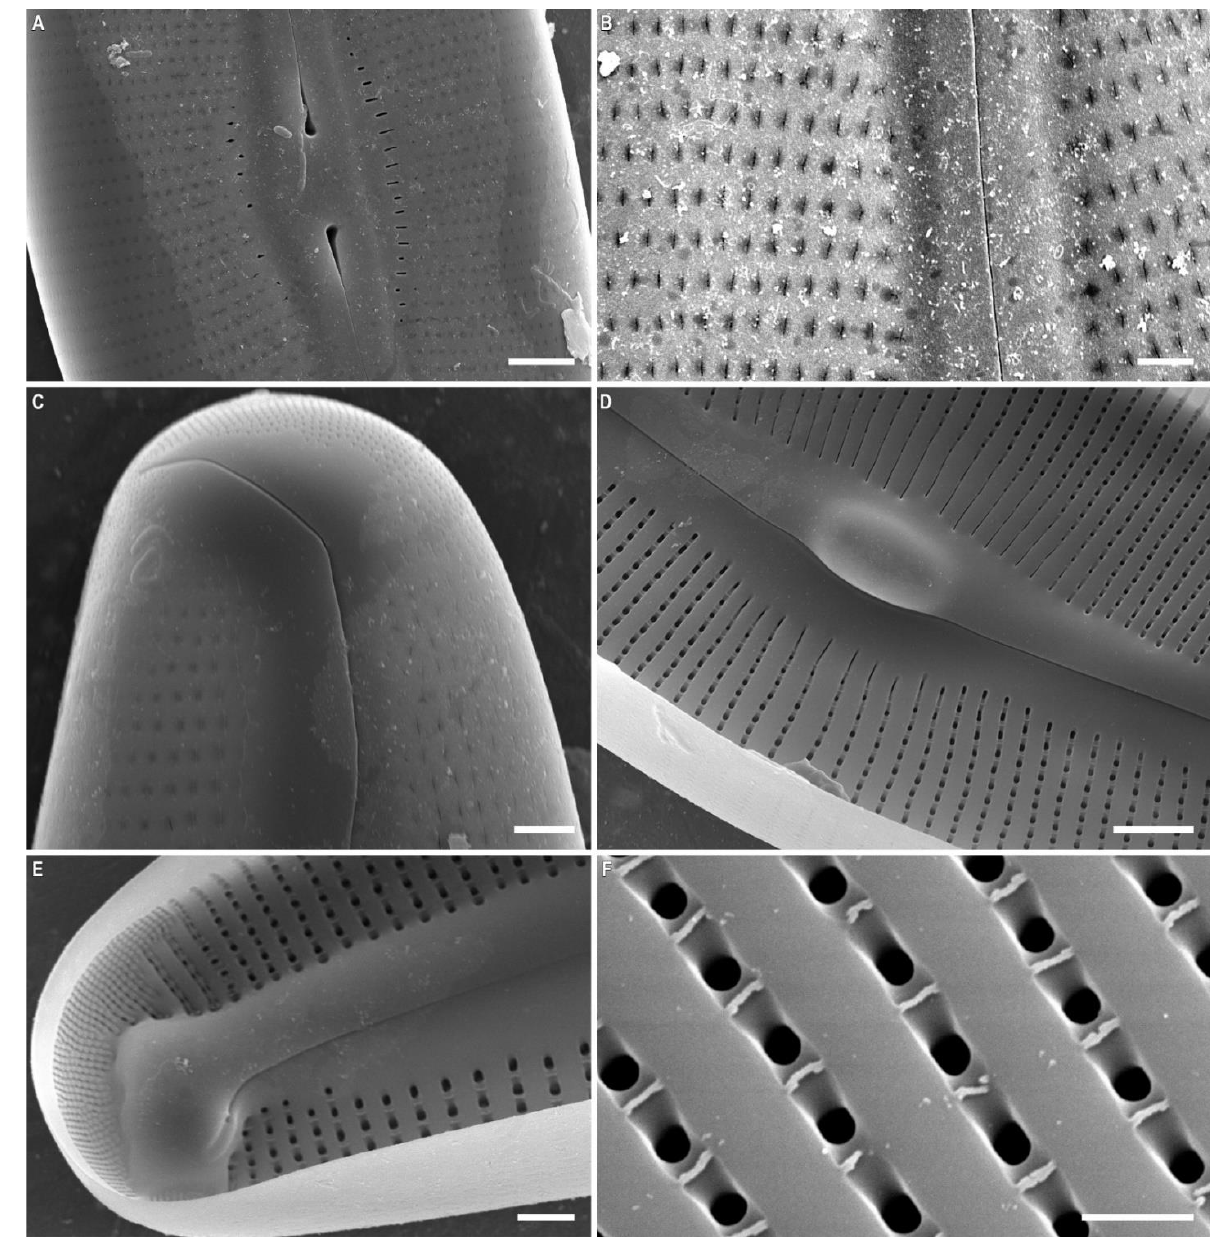
Figure 4. Cymbella himalaspera Jüttner and Van de Vijver in Jüttner et al. 2010. Strain B271. Scanning electron microscopy. ( A – C ) External views. ( D – F ) Internal views. ( A , D ) Central area. ( B , C , E , F ) Valve ends. Areolae. Scale bars ( A , D ) = 5 μm; ( B , C , E ) = 2 μm, ( F ) = 1 μm. Striae are uniseriate, extending from the valve face and onto the mantle on both dorsal and ventral margins. Areolar openings are X-, Y-, star- or tree-shaped closer to central part of valve, becoming longitudinal slits towards the apices.